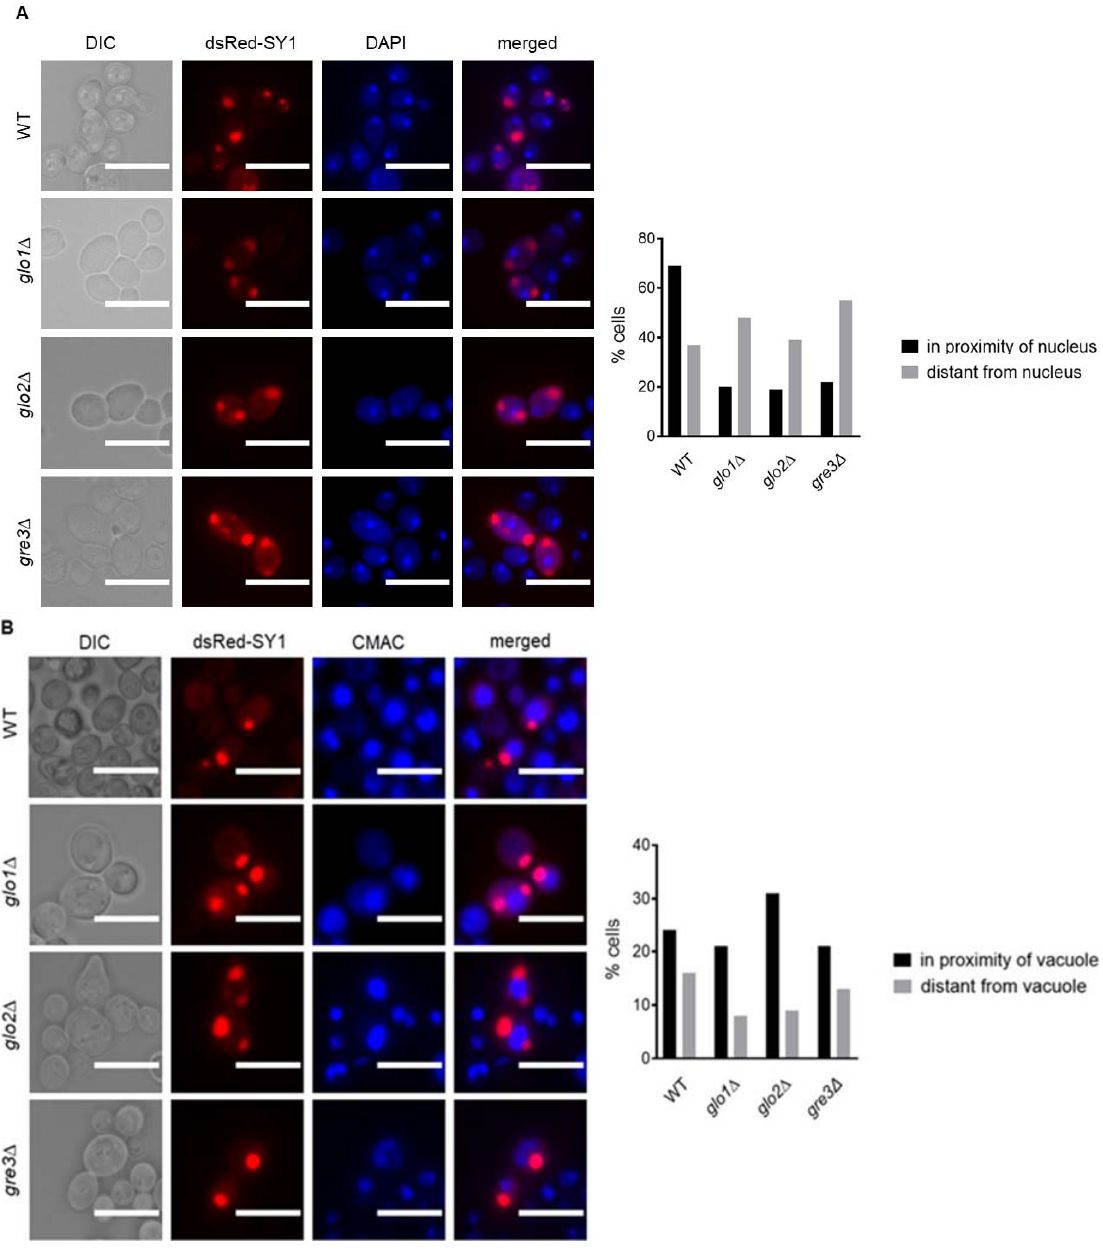
Figure 6. Nuclear ( A ) and vacuolar ( B ) staining of dsRed ‐ SNCAIP ‐ expressing S. cerevisiae wt, glo1 ∆ , glo2 ∆ , and gre3 ∆ strains. A preliminary quantification of dsRed ‐ SY1 inclusion localisation was performed based on 100 inclusions in less than 50 cells of one clone per strain. The scale bars represent 10 μ m. SY1 = Synphilin ‐ 1.